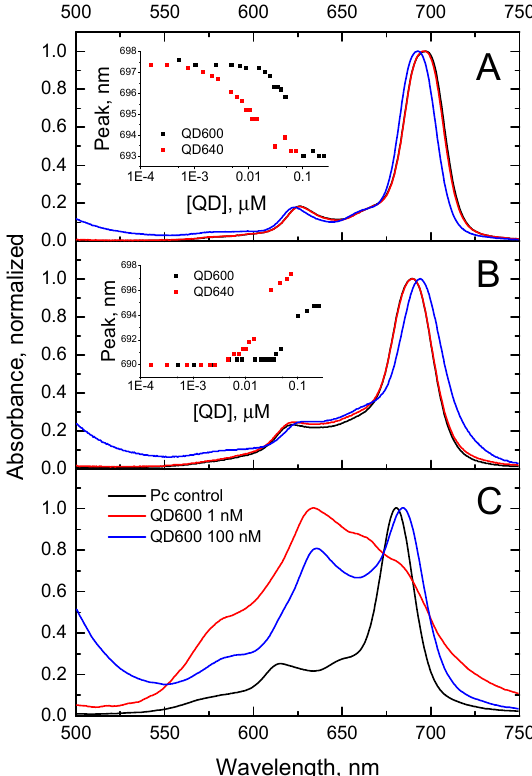
Figure A4. Normalized absorption spectra of carboxyphthalocyanines AlPc8 ( A ), ZnPc8 ( B ), and ZnPc16 ( C ) in the long-wavelength region in an aqueous solution and in the presence of various concentrations of QD600. The insets show the position of the Q I absorption band of the Pc depending on the QD concentration of in the